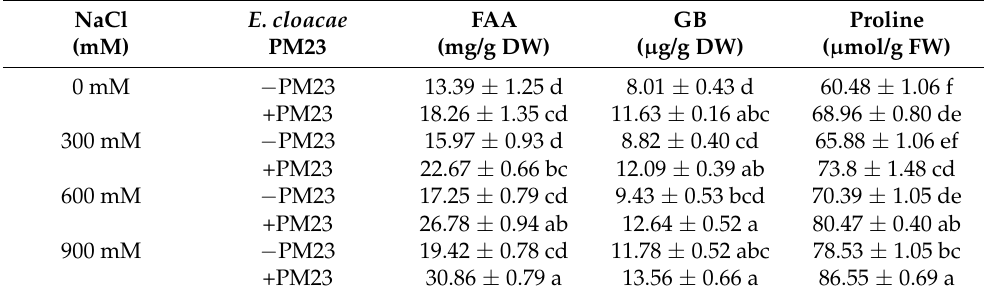
The effect of NaCl treatments under different salt concentration conditions. FAA–Amino Acid, GB–Glycine betaines. The treatments exhibit dissimilar letters within rows that represent signifi- cance ( p ≤ 0.05) level.